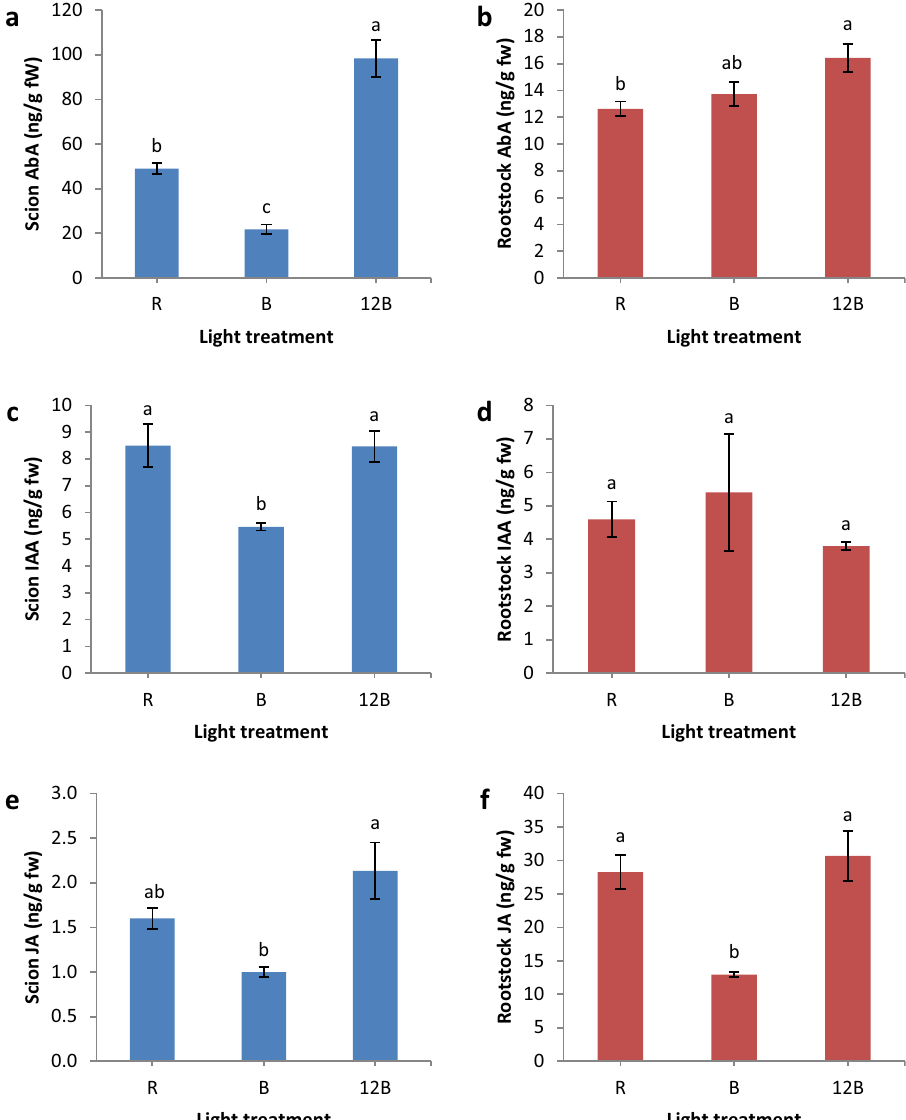
Figure 4. Abscisic acid (AbA) ( a , b ), indole-3-acetic acid (IAA) ( c , d ), and jasmonic acid (JA) ( e , f ) of scion ( a , c , e ) and rootstock ( b , d , f ) segments of grafted watermelon seedlings under three light treatments in the healing chamber at three days after grafting. Bars (± SE) followed by different letters are significantly different (a < 0.05). Mean values derived from n = 3